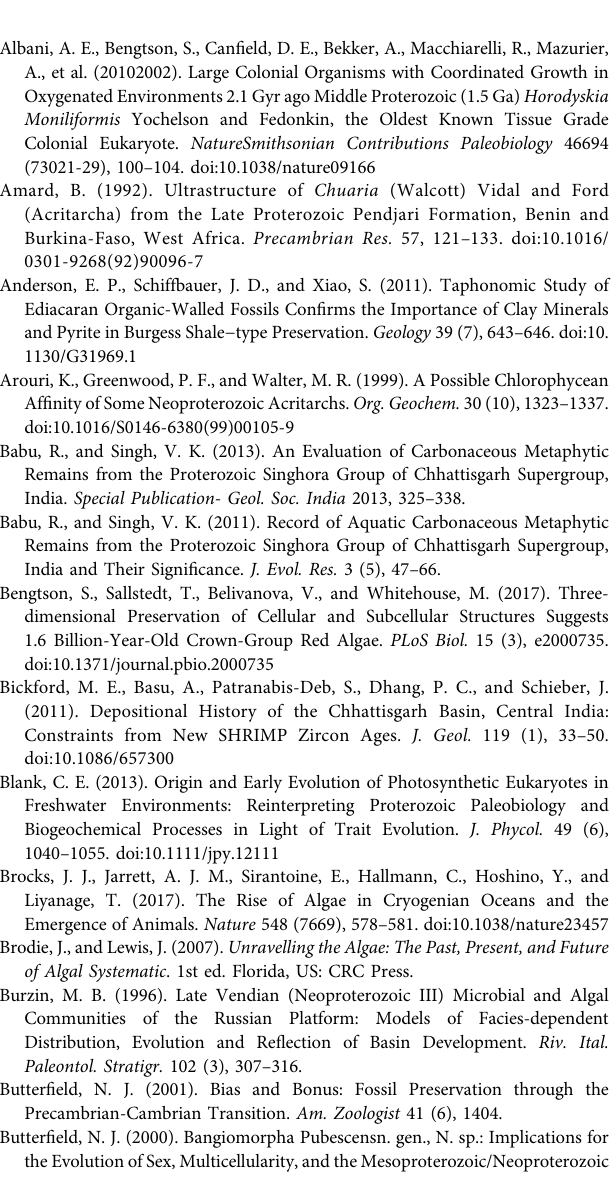
Supplementary Figure S2 | Schematic drawing showing mode of preservation of Palaeoscytosiphon shuklaii at different stages (1 – 4) . Scale bar is 2.0 mm for each.